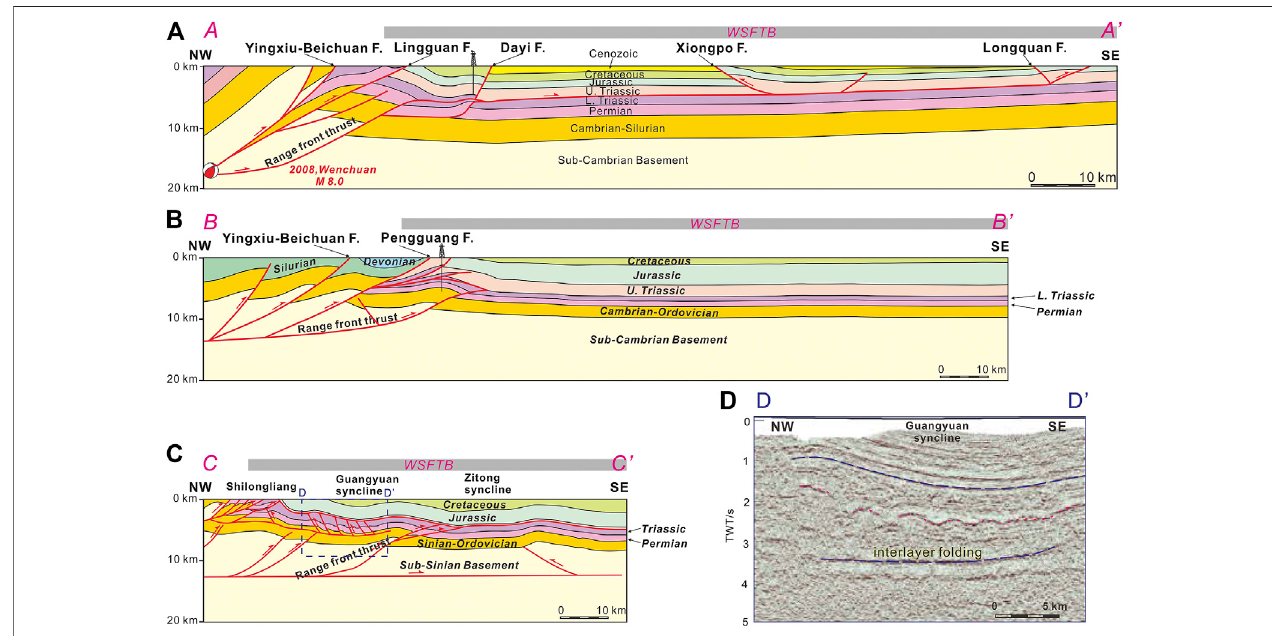
FIGURE 2 | (A and B) Cross sections across the southern and central segment of WSFTB (after Li, 2014). (C) Typical cross section from the northern segment of WSFTB , modi fi ed from Li. (2014) and Chen et al. (2019); (D) New obtained high-resolution seismic pro fi le across the Guangyuan syncline from Chen et al. (2019), showing folding that con fi ned in the middle structural level. The locations of these four pro fi les are indicated on Figure 1 , roughly.